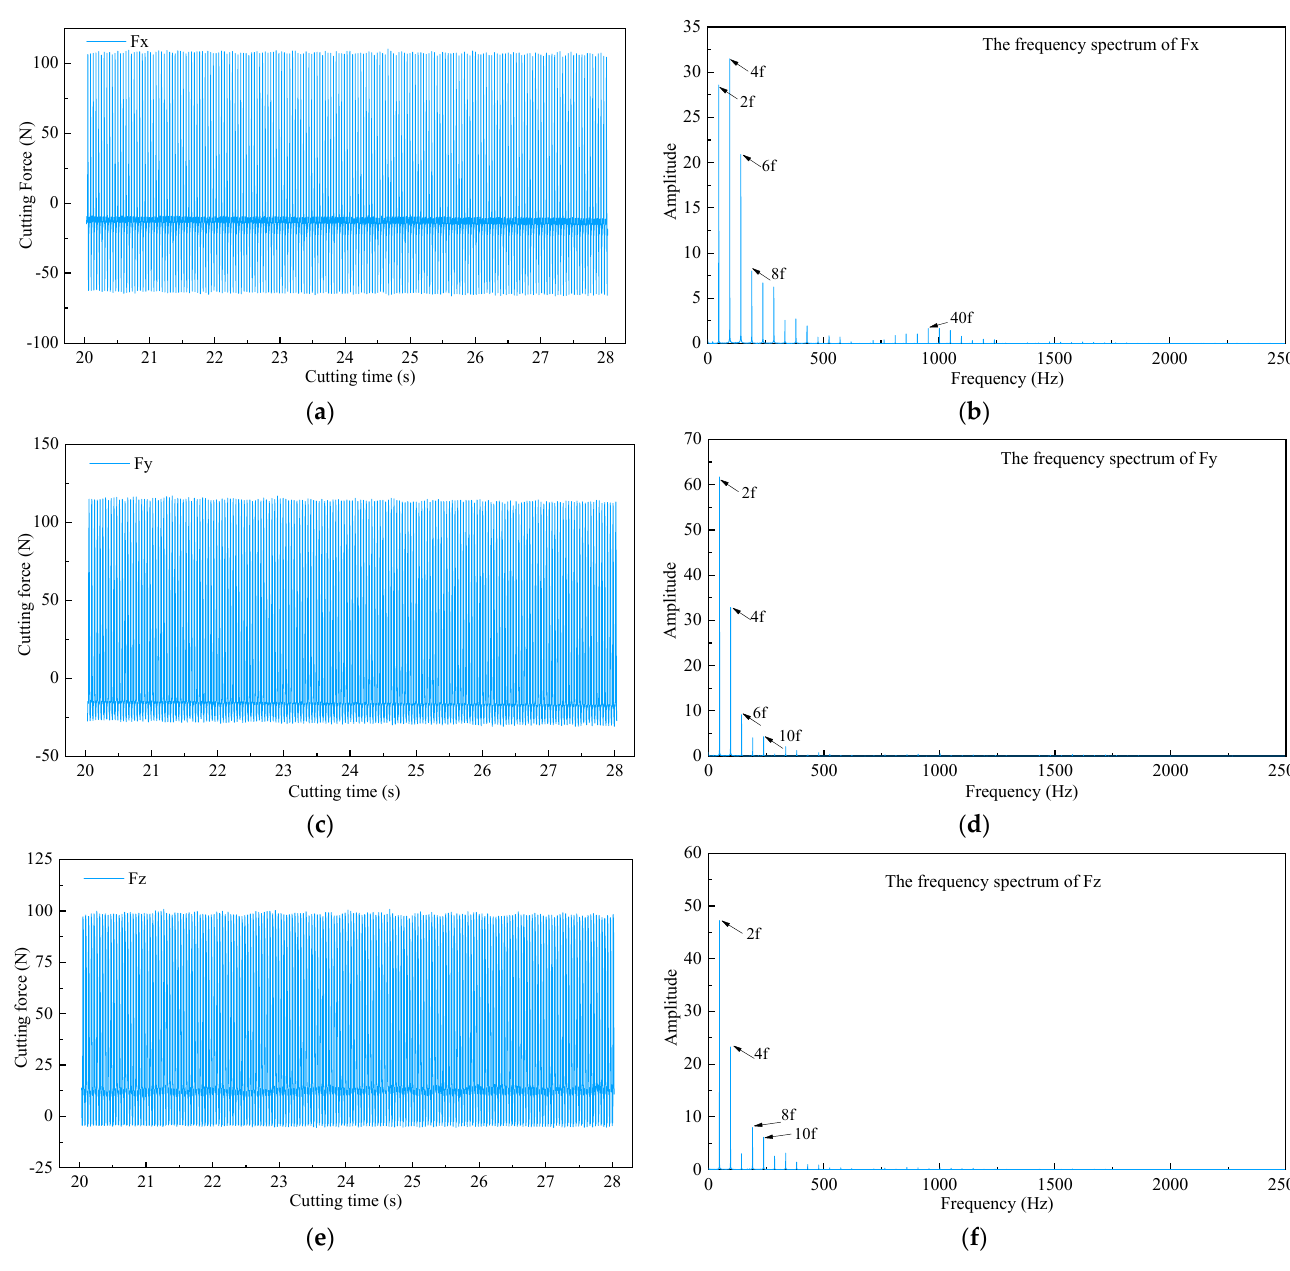
Figure 8. Original cutting force signals and corresponding frequency spectrum. ( a ) Fx component force in X direction; ( b ) The corresponding frequency spectrum of Fx; ( c ) Fy component force in Y direction; ( d ) The corresponding frequency spectrum of Fy; ( e ) Fz component force in Z direction; ( f ) The corresponding frequency spectrum of Fz.